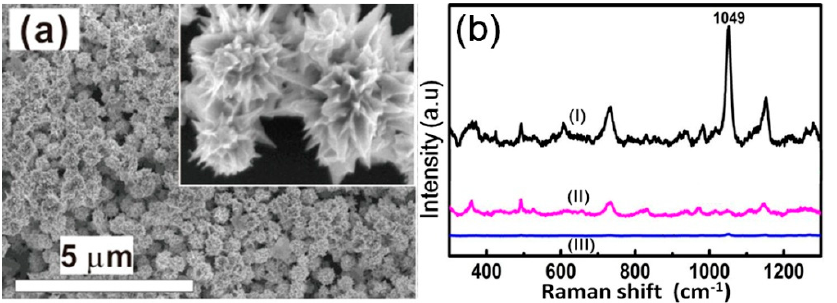
Figure 8. ( a ) The FESEM image of the as-prepared chestnut-like Au nanocrystals-built film (~500 nm in thickness) on a silicon substrate. The inset is the local magnified image. ( b ) The Raman spectra of the chestnut-like Au nanocrystals-built film after argon plasma bombardment for different times. Curves (I, II, III): after bombardment for 0 min, 5 min, and 10 min, respectively.